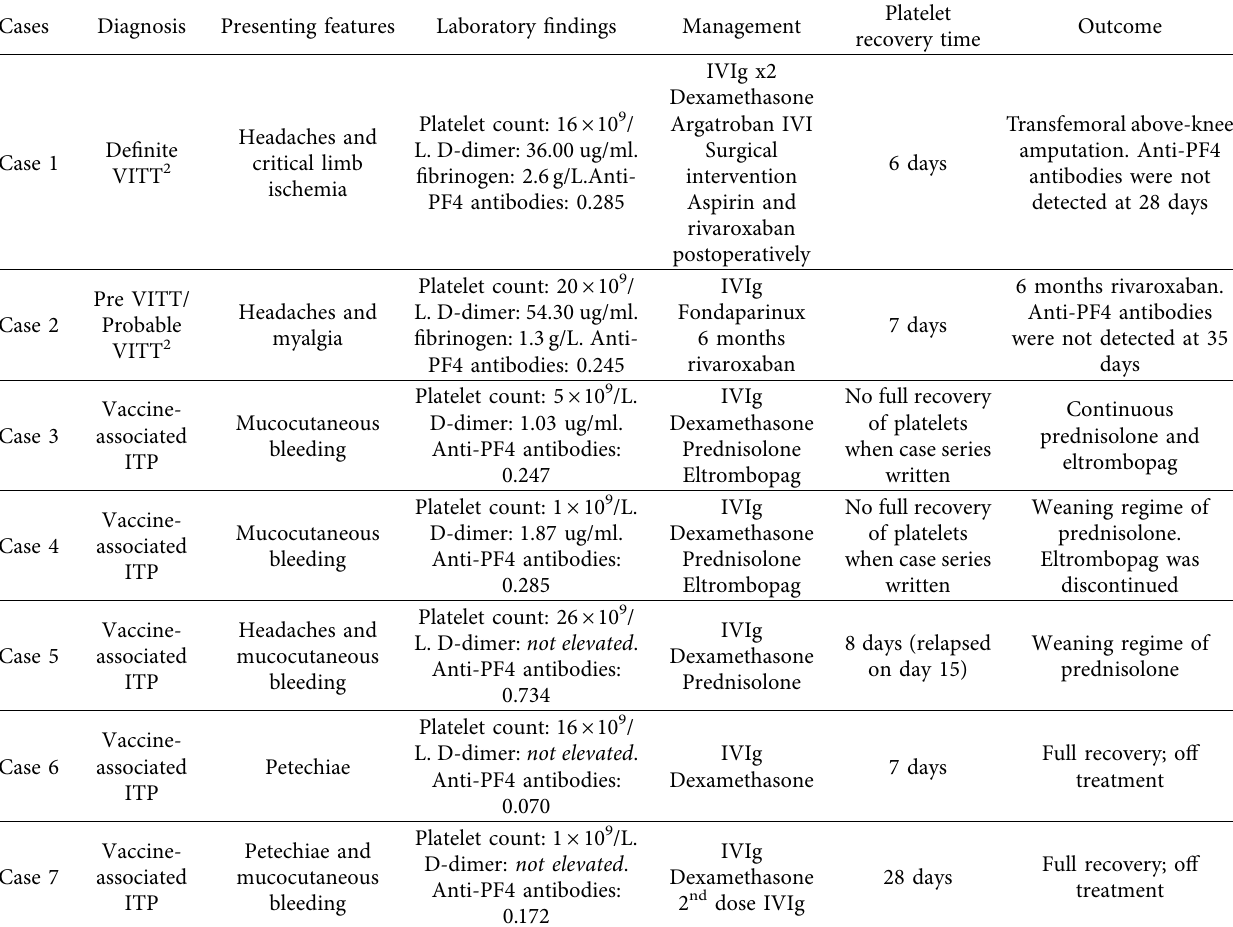
Table 1: A summary of the patients included in this case